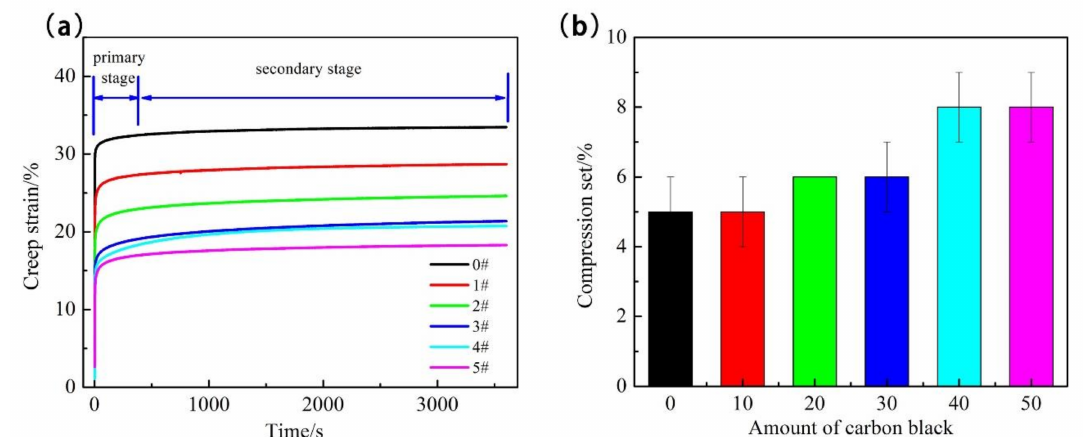
Figure 6. Creep behavior ( a ) and compression set ( b ) of unfilled and filled